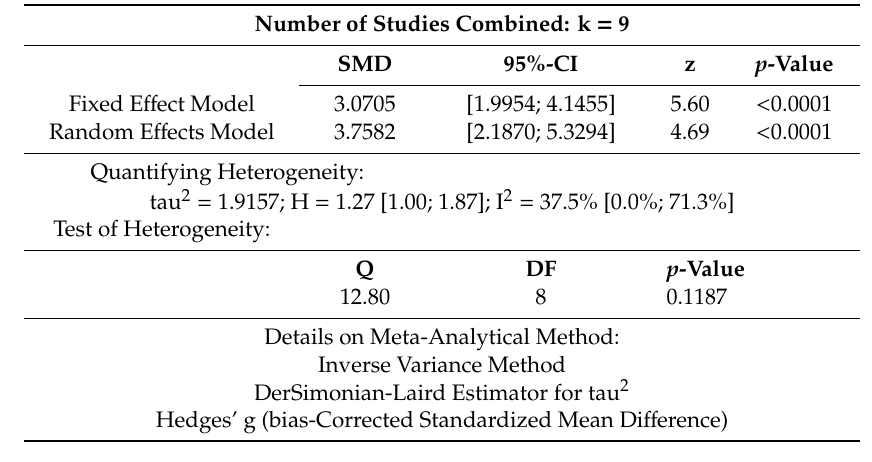
Table 13. Meta-analysis of